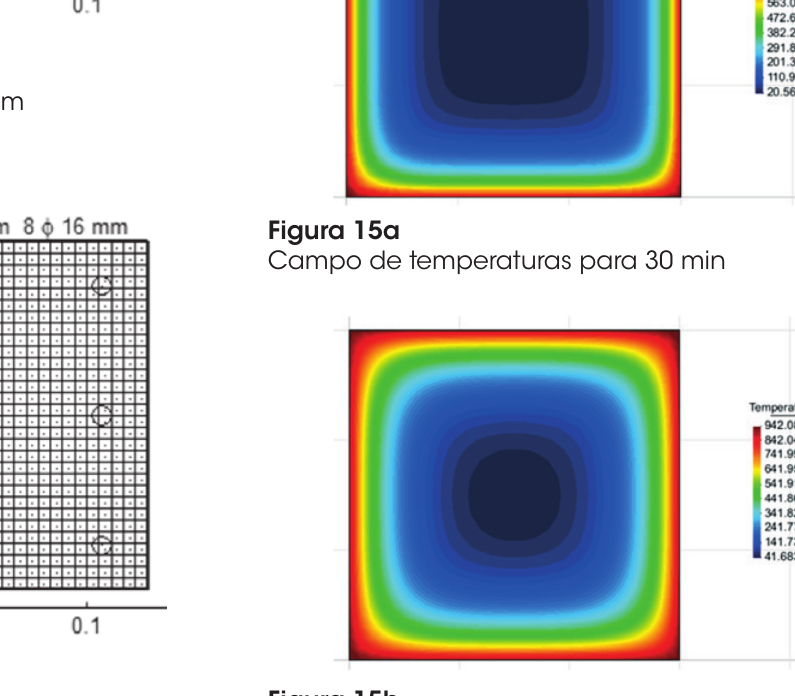
Figura 15b Campo de temperaturas para 60 min